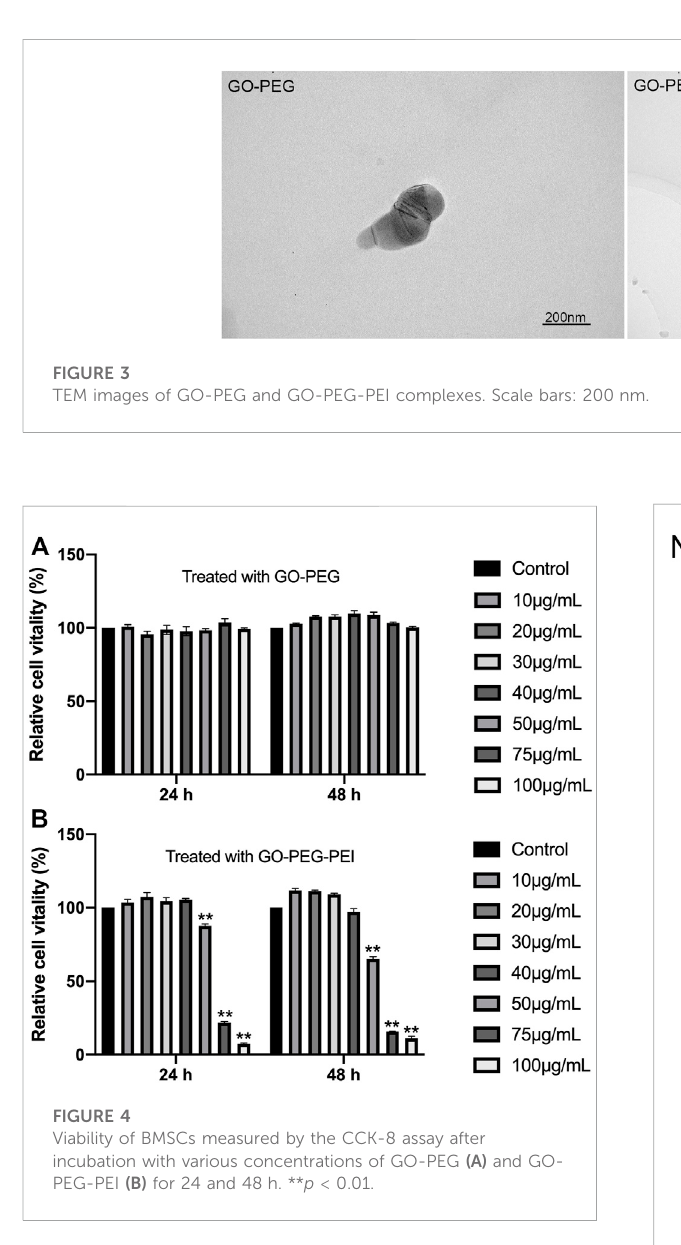
FIGURE 5 Gel retardation assay of the mixture of GO-PEG-PEI